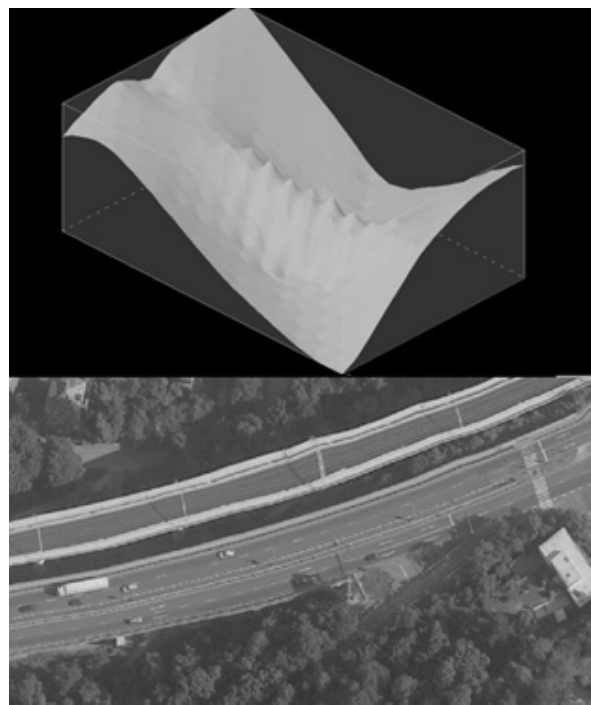
Figure 2. DMR 4G visualized as a shaded relief (left) and illustration of aerial photograph orthorectified via DMR 4G before replenishment by models of bridges (right)